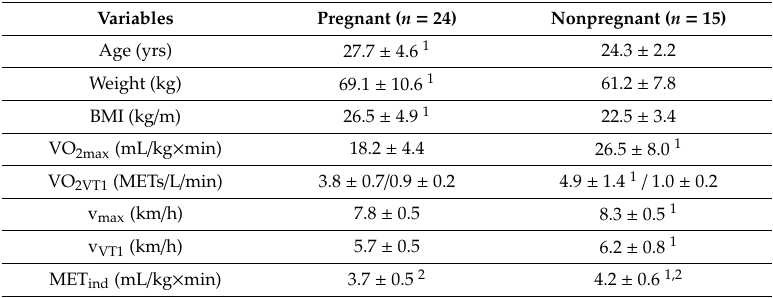
Table 1. Comparison of anthropometrics, performance of the incremental walking test (IWT), and the individual resting metabolic equivalent between pregnant and nonpregnant